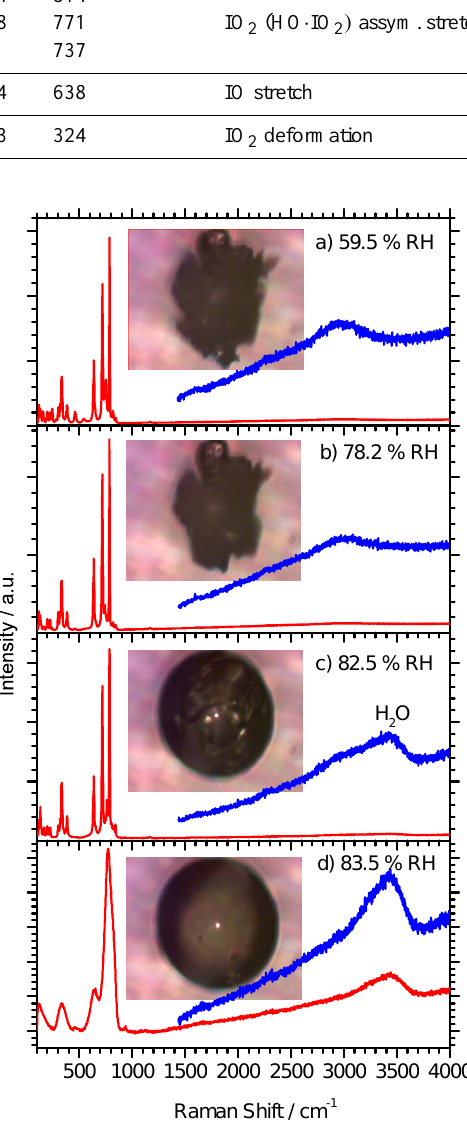
Fig. 2. Raman spectra of an initially crystalline HIO 3 particle on increasing RH. The blue spectra are the region above ∼ 1500cm − 1 expanded for clarity. Deliquescence occurs around 82.5% RH (c–d) and is clearly evident in changes in both the image of the droplets and the Raman spectra. The width of the microscope images is 160µm.